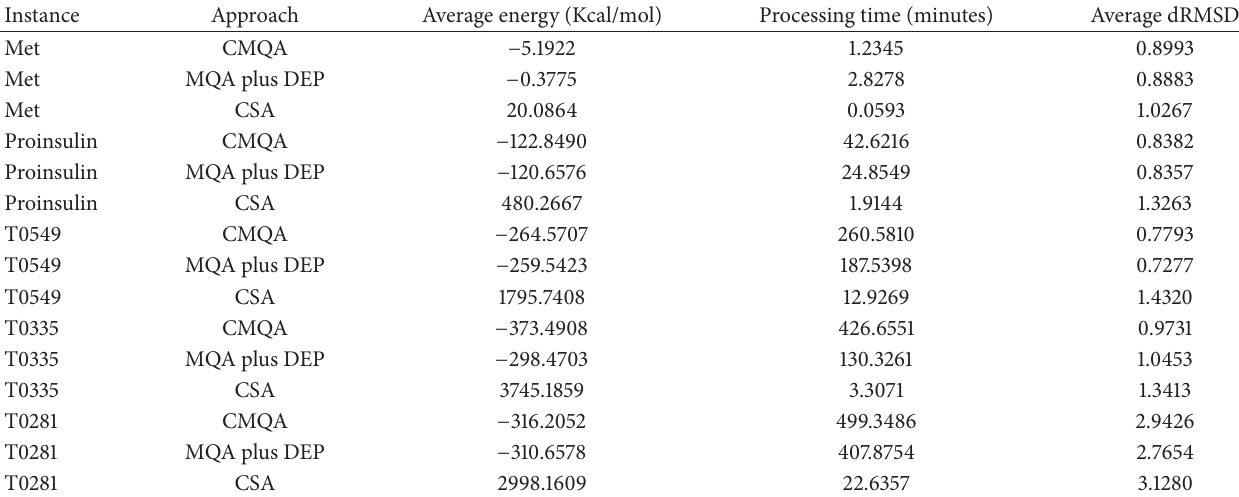
Table 7: Comparison of results with other